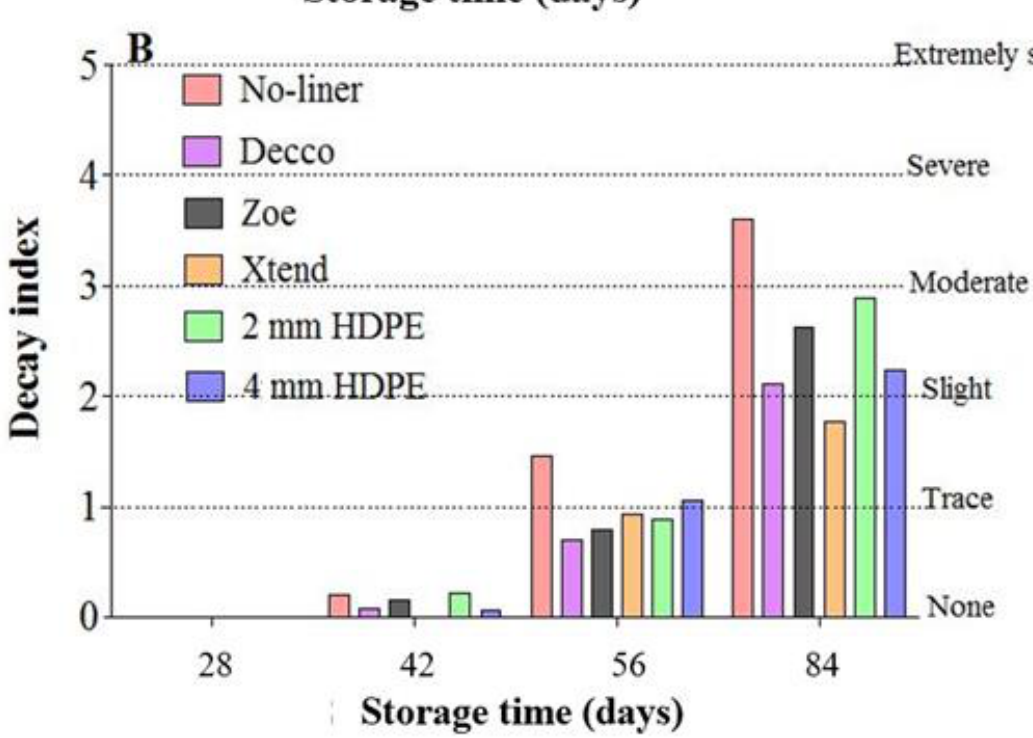
Figure 12. ( A ) Percentage cumulative decay incidence. ( B ) Cumulative decay index (severity). Pomegranate fruit stored for 84 d at 5 °C and 90% relative humidity (RH). HDPE: high density polyethylene.